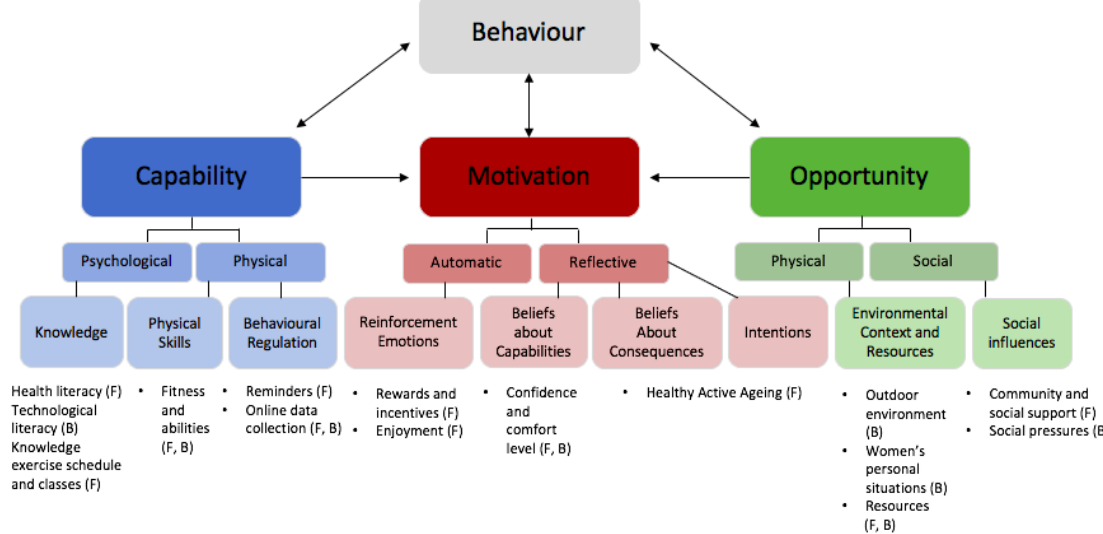
Figure 1. COM-B Framework, corresponding TDF domains and theme structure. The COM-B Framework component of this figure was adapted from McDonagh L et al. 2018 [47]. “B” represents a barrier to group physical activity and “F” represents a facilitator.